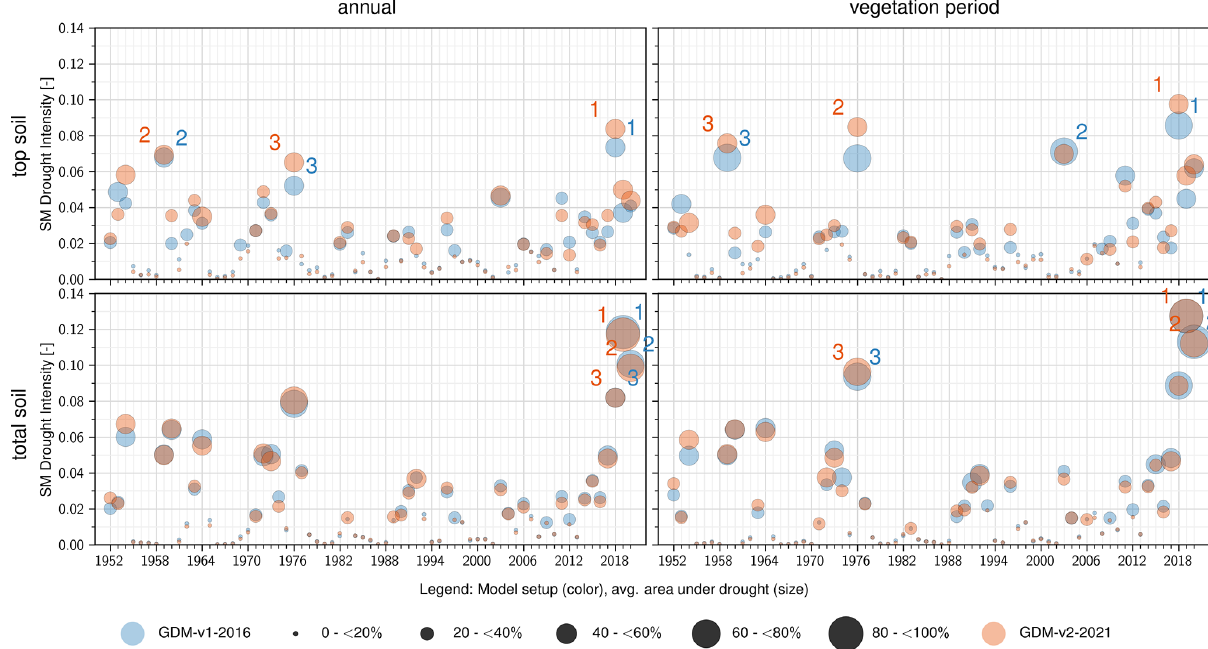
Figure 8. SM drought intensities spatially aggregated over Germany during the vegetative active period (April–October) in the top soil (5– 25cm) and total soil column (up to 2m). The size of the circles represents the average area under drought. The three largest drought events are numbered in each panel. Colors represent the two model